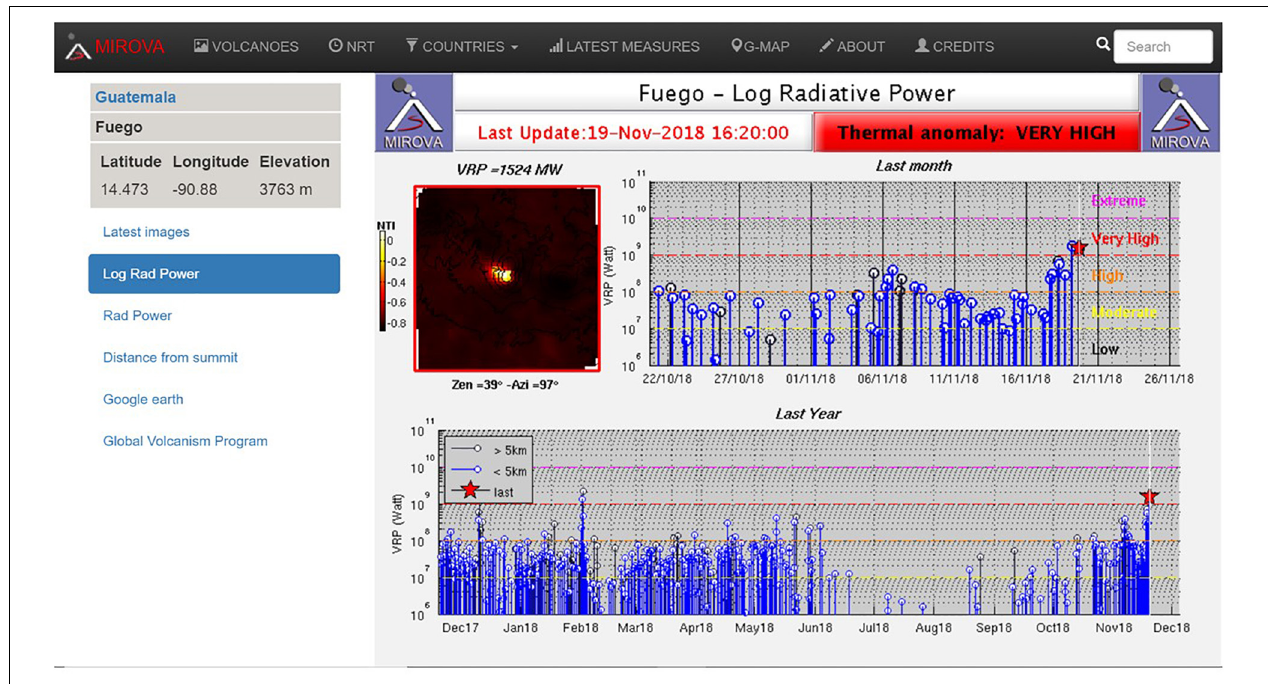
FIGURE 3 | Snapshot of the “ Log Radiative Power ” screen posted on the MIROVA website for the Fuego volcano, Guatemala (accessed on 19 November 2018). Note the fluctuations in thermal activity in the last month (top right panel), with an evident increase in VRP (almost 2 orders of magnitude) recorded from 14 to 19 November 2018. The trend of thermal anomalies recorded during the past year (lower panel) shows that after the eruption of the June 3, 2018 the thermal activity of Fuego was very low for at least 3 months. However, since September 2018 the radiate heat flux gradually intensified by means of repeated pulses culminating with the high VRP recorded on November 19,